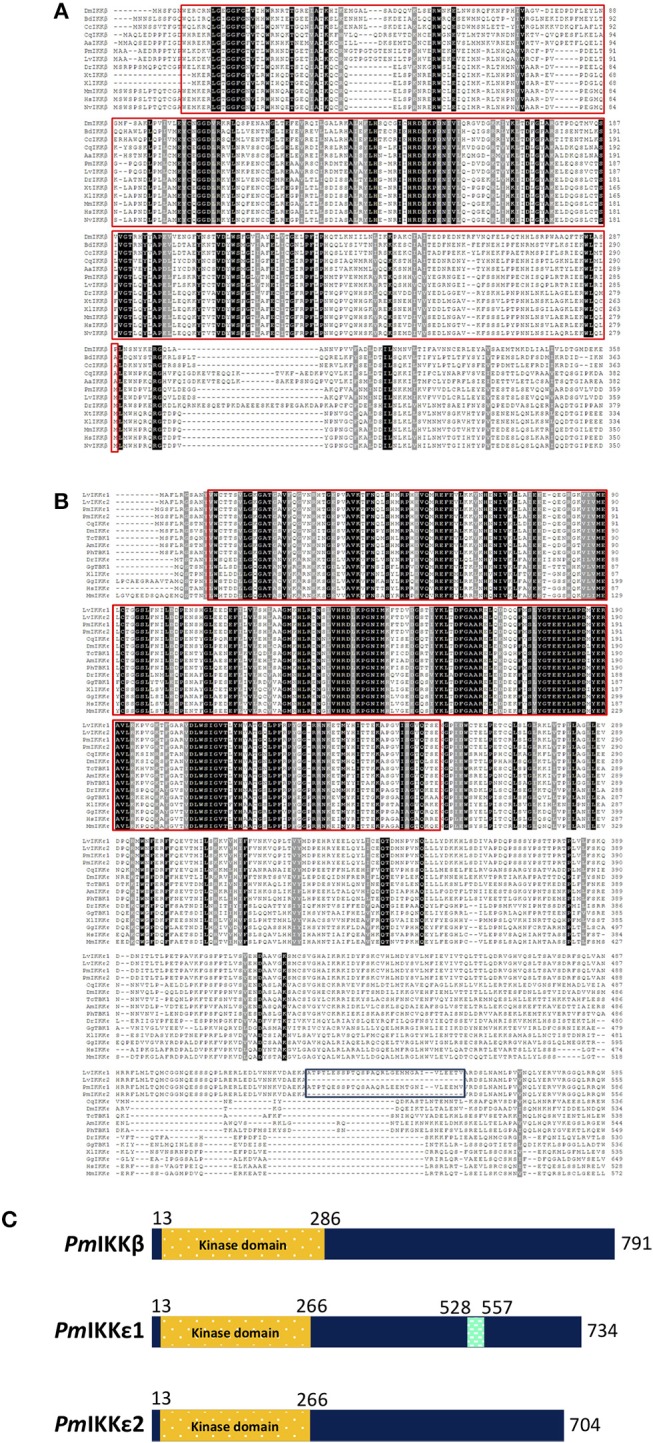
Sequence analysis of PmIKK and IKK family proteins from various typical species. Multiple sequence alignments of (A)
PmIKKβ and (B)
PmIKKε with IKK-family proteins were performed using Clustal Omega (https://www.ebi.ac.uk/Tools/msa/clustalo). The amino acid sequences of PmIKKβ, PmIKKε1, and PmIKKε2 were deduced by ExPASy-Translate tool (https://web.expasy.org/translate). Important protein motif features were predicted using Simple Modular Architecture Research Tool, SMART 8.0 (http://smart.embl-heidelberg.de). The conserved residues are shaded in black and gray. The important kinase domains at the N-termini are in the red boxes and the 30-amino acid regions of PmIKKε1 and LvIKKε1 are in the blue box below. (C) Schematic diagram of structural domain topology from PmIKKβ, PmIKKε1, and PmIKKε2 analyzed by SMART 8.0 program. N-terminal KDs are marked as yellow from amino acid residues 13 to 286 of PmIKKβ and amino acid residues 13 to 266 of PmIKKε1 and PmIKKε2. The PmIKKε1 contains unidentified domain from amino acid residues 528 to 557 at the C-terminus region. The amino acid sequences include; Penaeus monodon IKKβ (PmIKKβ, MK331816); Litopenaeus vannamei IKKβ (LvIKKβ, AEK86518); Mus muculus IKKβ (MmIKKβ, NP_001153246); Homo sapiens IKKβ (HsIKKβ, NP_001547); Xenopus tropicalis IKKβ (XtIKKβ, NP_001005651); Xenopus laevis IKKβ (XlIKKβ, NP_001085125); Danio rerio IKKβ (DrIKKβ, NP_001116737); Drosophila melanogaster IKKβ (DmIKKβ, AAG02485); Culex quinquefasciatus IKKβ (CqIKKβ, XP_001865661); Mustela putorius IKKβ (MpIKKβ, XP_004775760); Bactrocera dorsalis IKKβ (BdIKKβ, XP_011211311); Ceratitis capitatal IKKβ (CcIKKβ, XP_004537145); Aedea aegypti IKKβ (AaIKKβ, XP_001656614); Penaeus monodon IKKε1 (PmIKKε1, MK331817); Penaeus monodon PmIKKε2 (PmIKKε2, MK331818); Litopenaeus vannamei IKKε1 (LvIKKε1, AEK86519); Litopenaeus vannamei IKKε2 (LvIKKε2, AEK86520); Culex quinquefasciatus IKKε (CqIKKε, XP_001848400); Drosophila melanogaster IKKε (DmIKKε, NP_724278); Apis mellifera IKKε (AmIKKε, XP_396937); Xenopus laevis IKKε (XlIKKε, NP_001089830); Danio rerio IKKε (DrIKKε, NP_001002751); Gallus gallus IKKε (GgIKKε, XP_428036); Homo sapiens IKKε (HsIKKε, NP_054721); Mus musculus IKKε (MmIKKε, EDL39711); Gallus gallus TBK1 (GgTBK1, NP_001186487), Tribolium castaneum TBK1 (TcTBK1, XP_969718) and Pediculus humanus TBK1 (PhTBK1, XP_002428501).